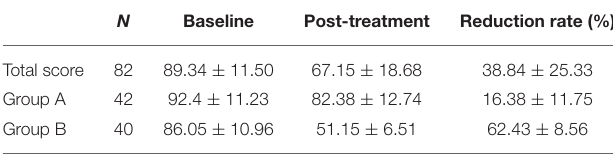
TABLE 2 | PANSS score reduction rate and grouping after 4 weeks of